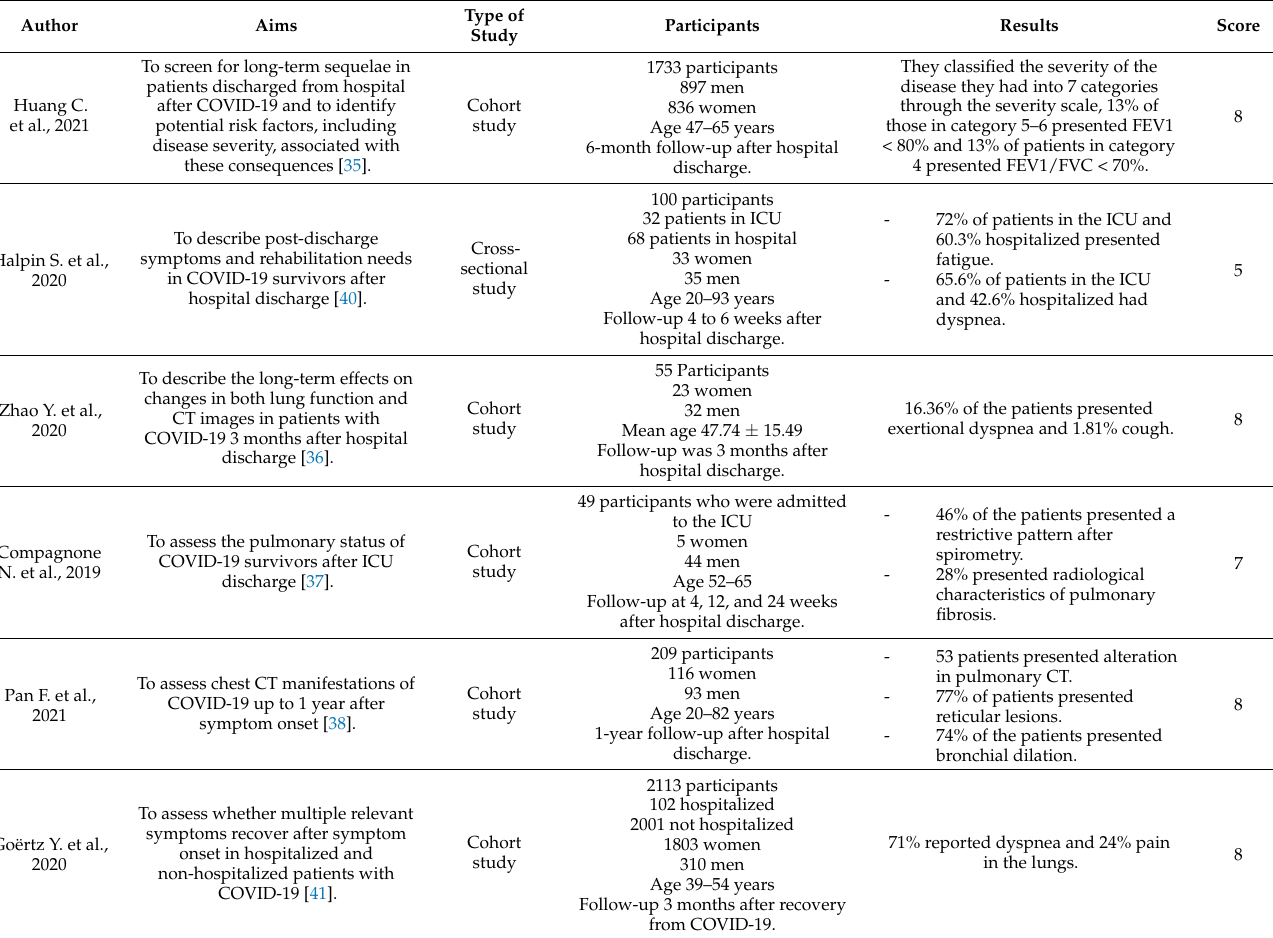
Table 1. Summary of the literature mentioning pulmonary